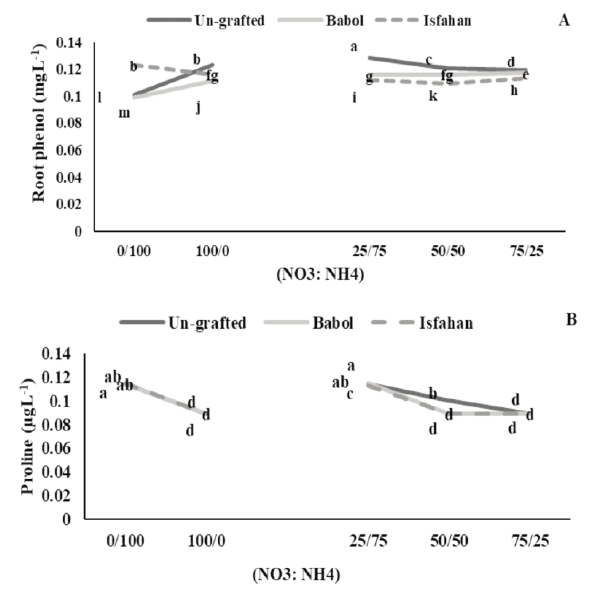
Fig. 5 ­ The interaction effect of different rootstocks and NO :NH ratio on A) proline and B) root phenol. 3 4